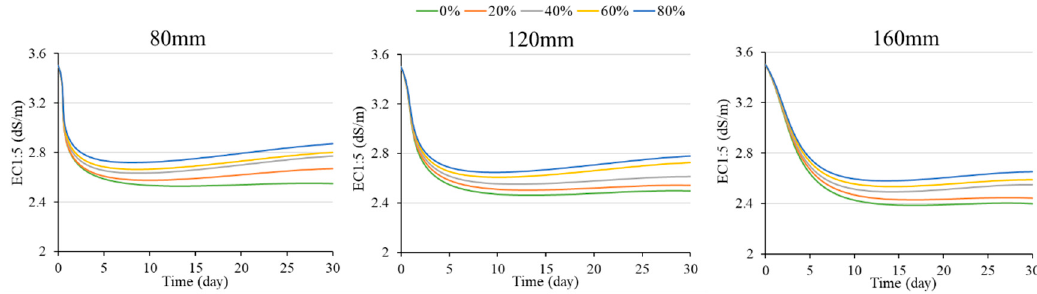
Figure 9. Time variations of HYDURS model simulated root zone (0–40 cm) salinity for different leaching amounts and seawater mixture rates.